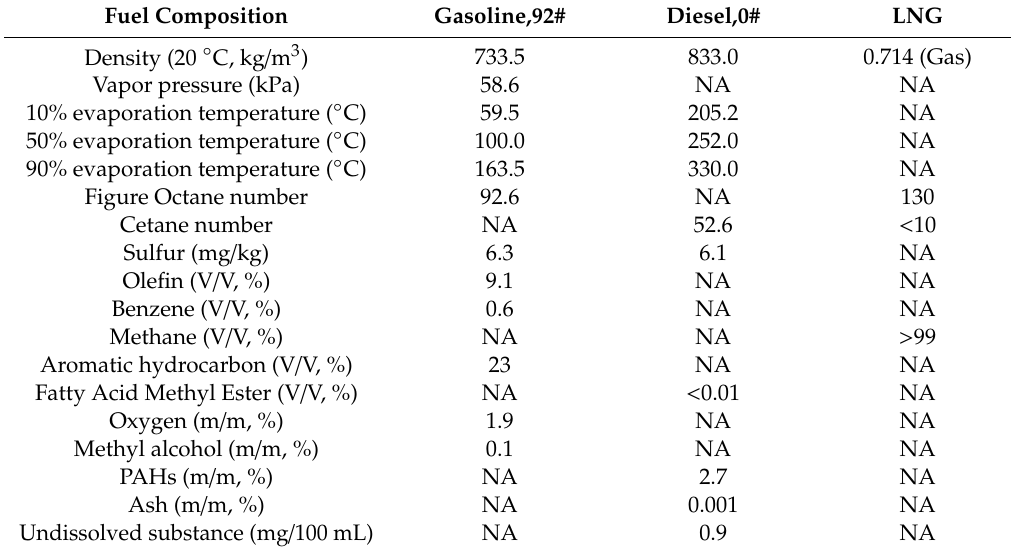
Table A2. The fuel composition of Gasoline,92#, Diesel,0# and